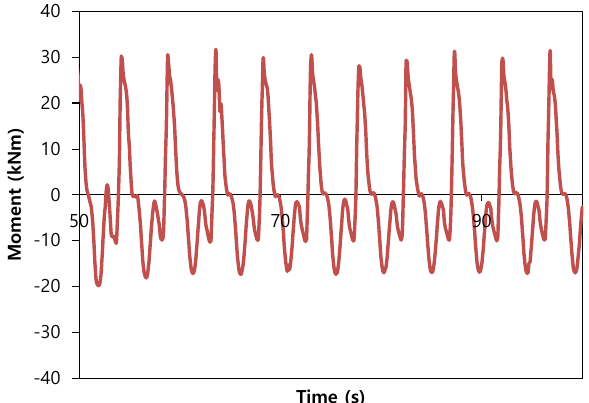
load torque in the numerical analysis as a uni-directional PTO system that gives a torque only if the pitch angular velocity is positive.